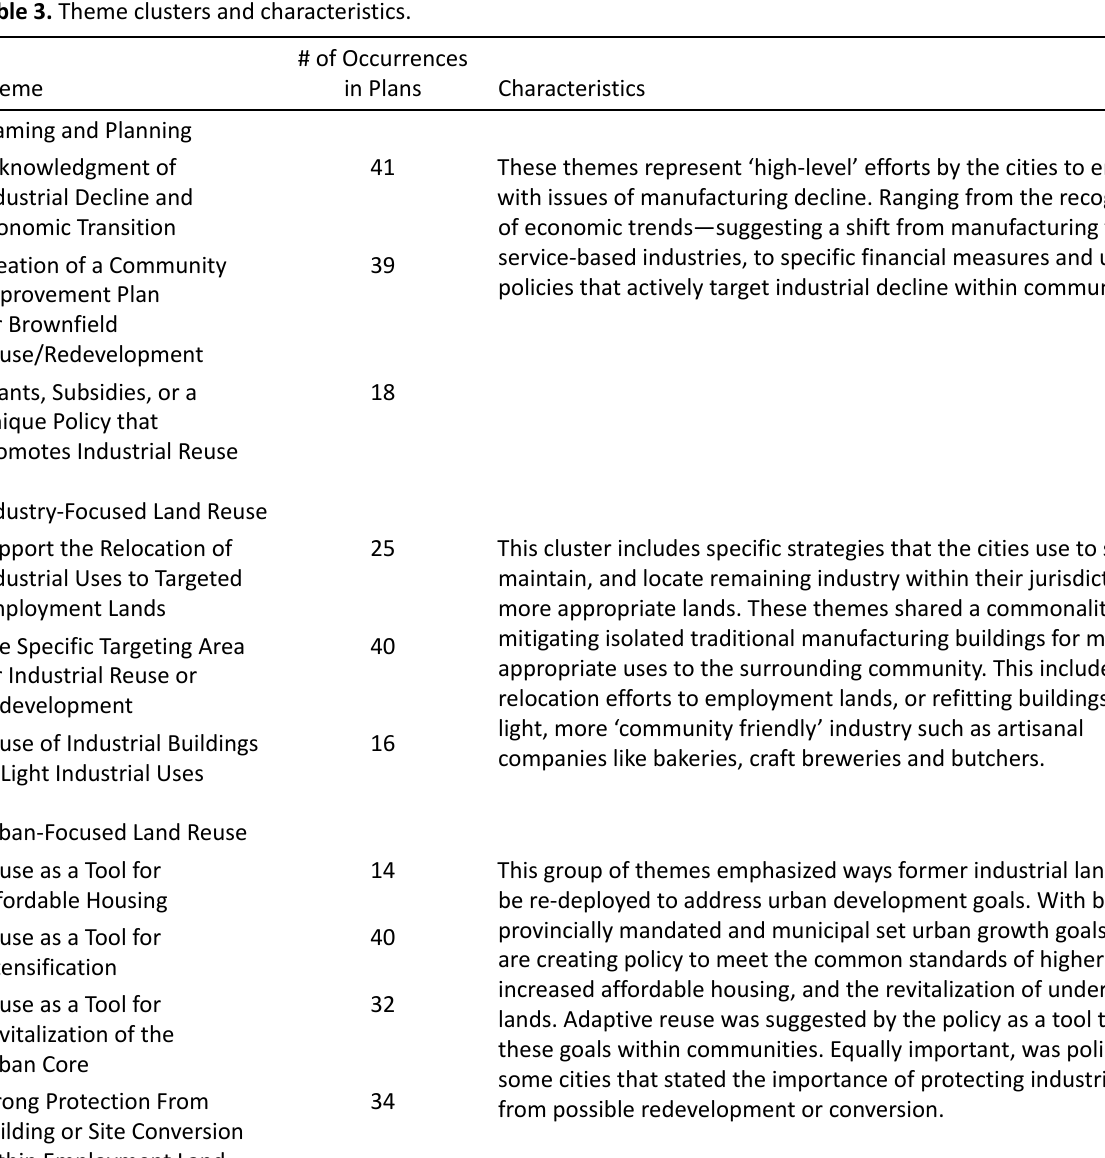
Table 3. Theme clusters and